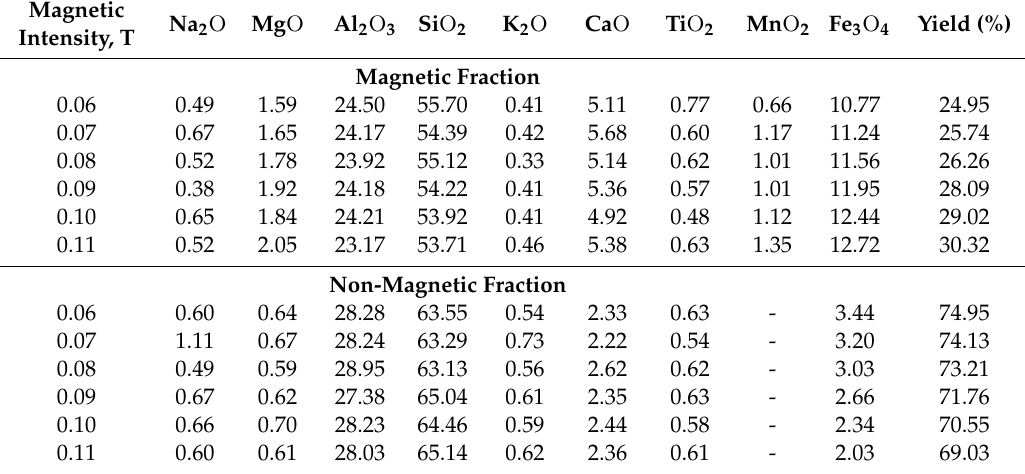
Table 3. Chemical composition (wt %) of the magnetic and non-magnetic fractions after wet magnetic separation of the raw CFA